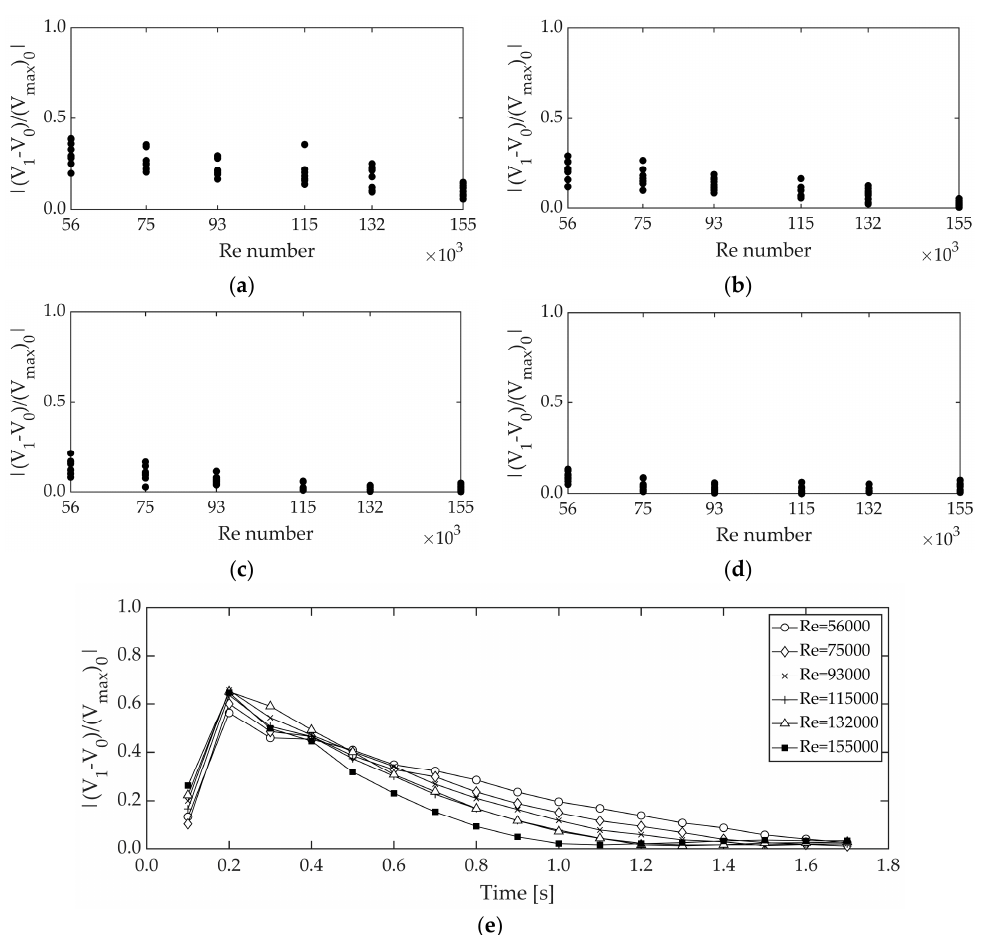
Figure 10. Difference between the transient mean velocity (V 1 ) and the initial mean velocity (V 0 ) over the maximum initial velocity (V max ) 0 for all the tested conditions and time steps after starting the transient event as: ( a ) 0.8; ( b ) 1.0; ( c ) 1.2; ( d ) 1.4; ( e ) for more time.